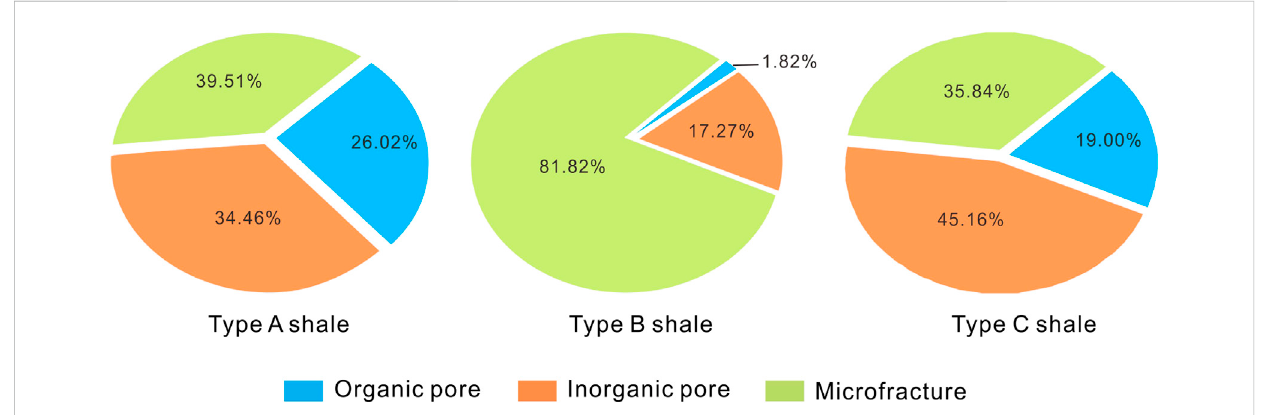
FIGURE 6 Histogram showing proportion of reservoir spaces of Jurassic Lianggaoshan Formation lacustrine shale in different lithology combination.